Question: What style of plot is this figure drawn as?
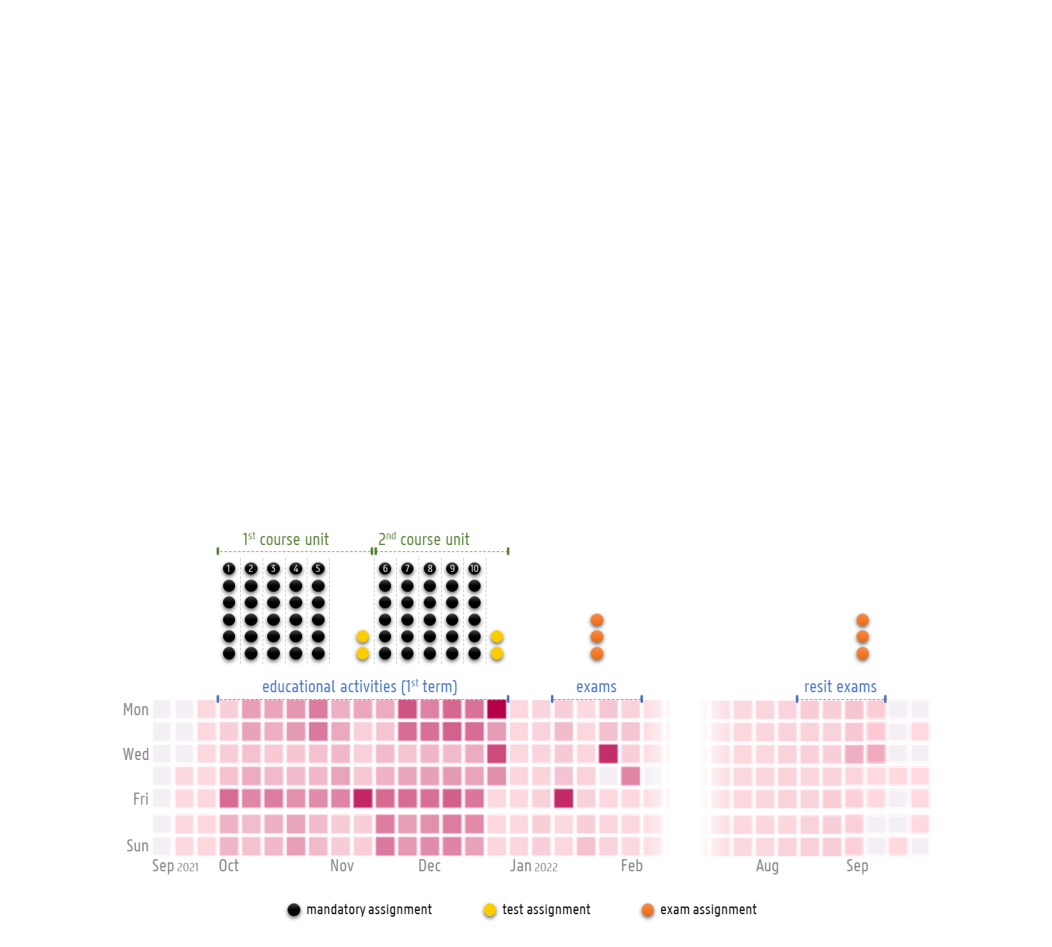
Answer: heatmap